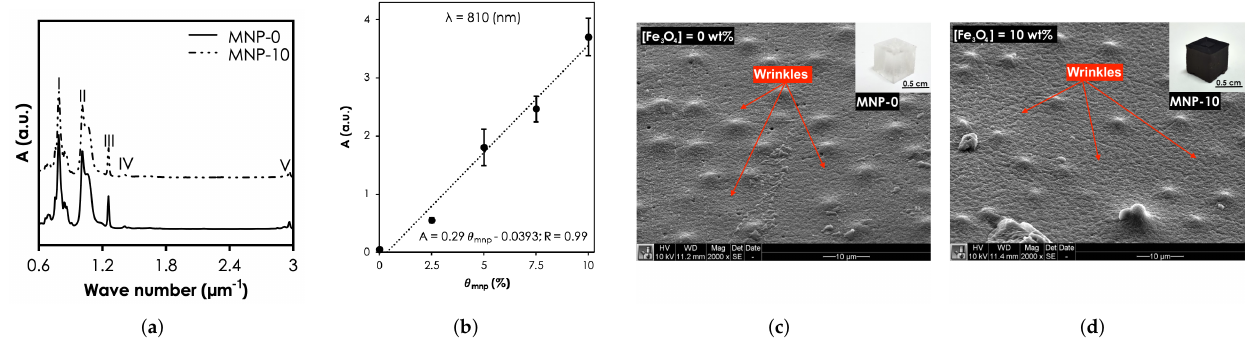
Figure 5. Structural and optical characterization SNCs results. ( a ) Fourier Transform Infrared spectra of all samples. ( b ) The UV-vis-NIR absorbance intensity of the nanocomposites at 810 nm. Scanning Electron Microscopy of ( c ) MNP-0 and ( d )